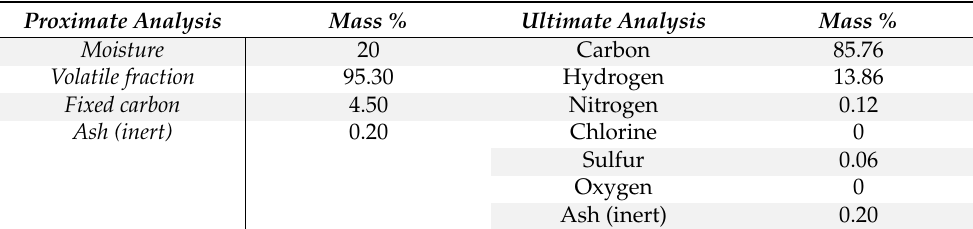
Table 1. Proximate and ultimate analysis of the adopted paper pulper. Table 2. Composition of the produced syngas.